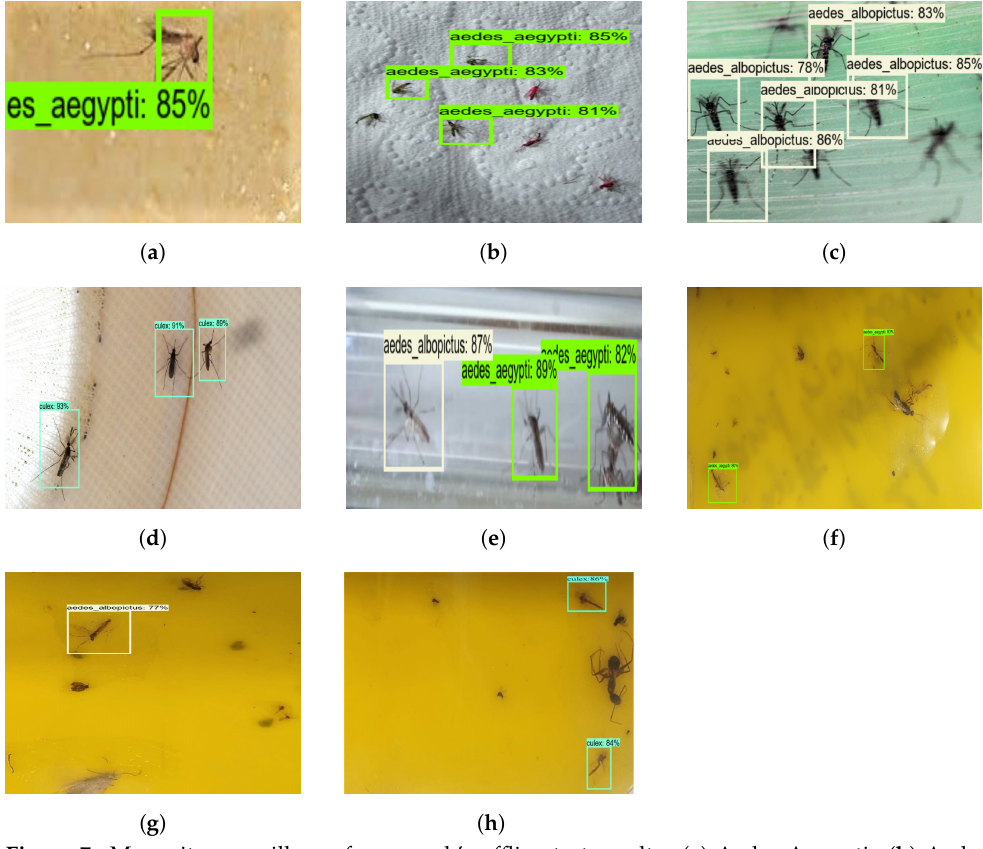
Figure 7. Mosquito surveillance framework’s offline test results. ( a ) Aedes Aegypti. ( b ) Aedes Aegypti. ( c ) Aedes Albopictus. ( d ) Culex. ( e ) Aedes Albopictus and Aedes Aegypti. ( f ) Aedes Aegypti. ( g ) Aedes Albopictus. ( h ) Culex.